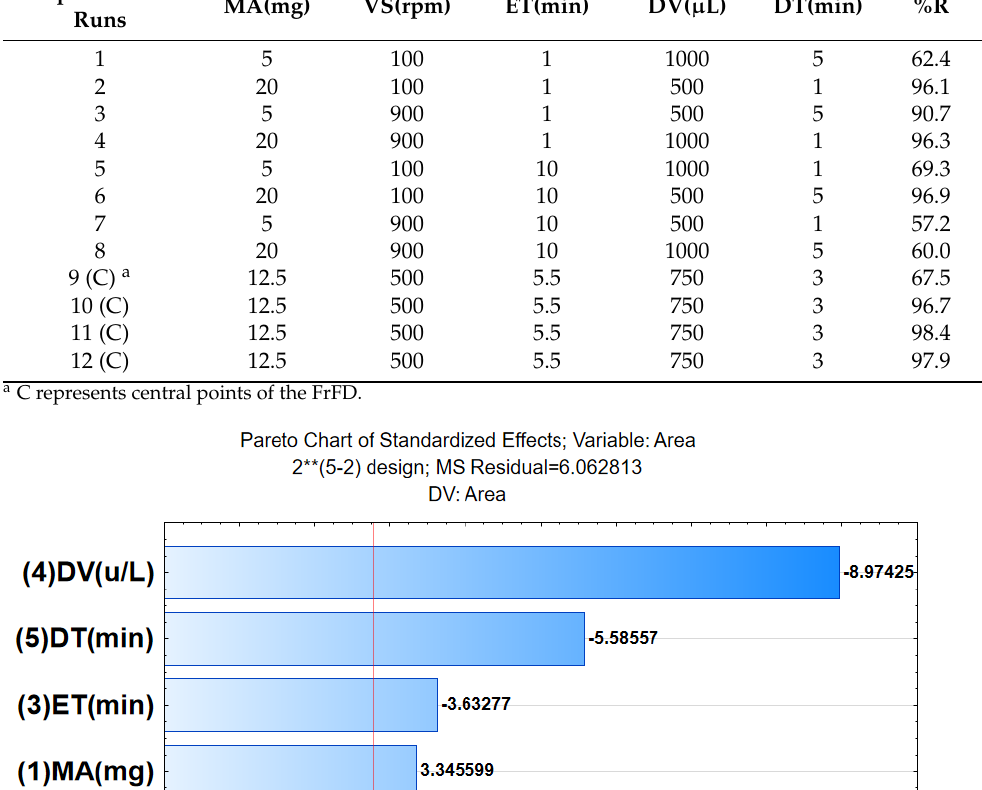
Table 4. Design matrix with respective experimental analytical responses obtained using screening process using 2-level FrFD during the extraction and pre-concentration of ACT using VA-d- µ -MISPE. Experimental